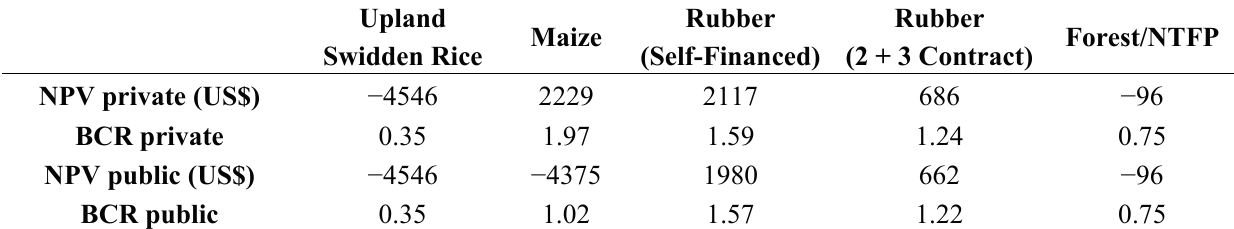
Table 4. Results of the mean NPV and Benefit Cost Ratio (BCR) analyses for all land use options (per ha).